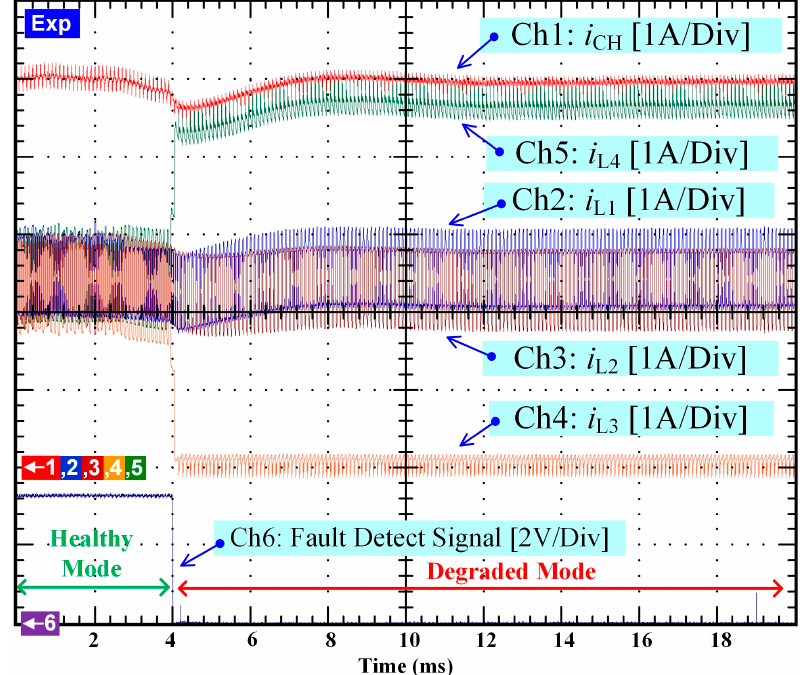
Figure 14. Obtained experimental results showing the transient and accommodation after fault.